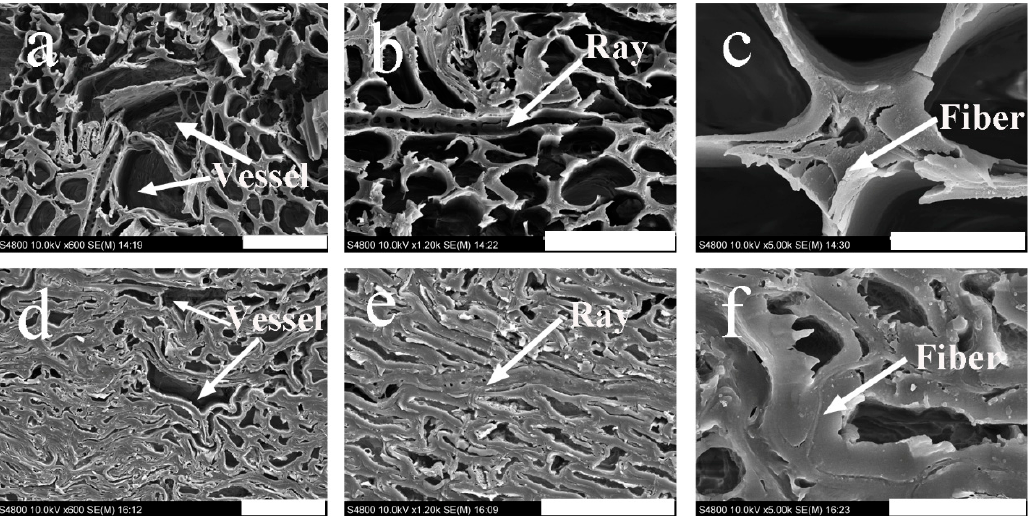
Figure 10. SEM images of OWMEC with different densities after 12 weeks of incubation with T. versicolor fungi. ( a – c ): 0.85 g/cm 3 ; ( d – f ): 1.15 g/cm 3 . Scale bars: ( a , d ): 50 µm; ( b , e ): 40 µm; ( c , f ): 10 µm.